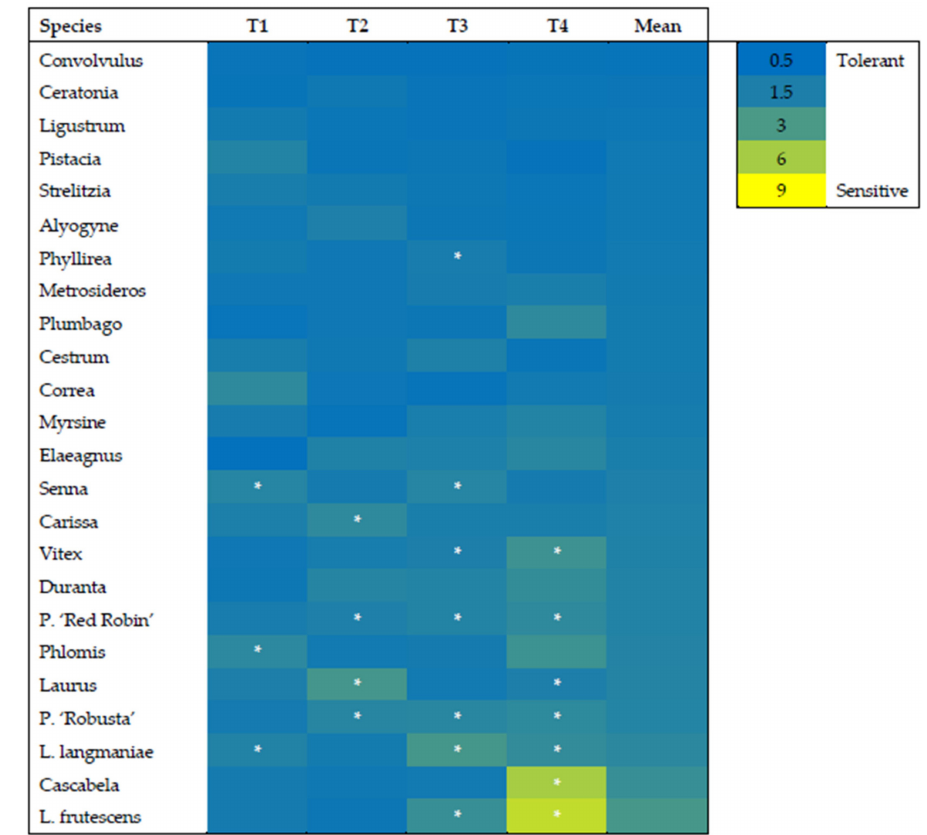
Figure 4. HeatMap of the Net photosynthesis (AN) ratio between control and aerosol treatments in twenty-four species of ornamental shrubs exposed to salt spray. Plants were subjected twice a week to nebulization treatment with simulated seawater solution for 60 days. At the beginning and every 20 days [T1 (0 days), T2 (20 days), T3 (40 days), T4 (60 days)] of the experimental period, the ratio was calculated. The asterisks depict statistically significant di ff erences between control and treated plants for each species as determined by Tukey’s test ( p < 0.05).